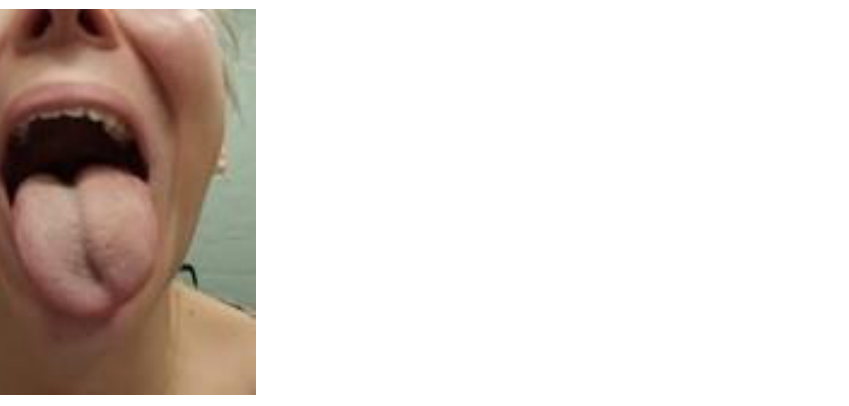
Figure 6. The patient’s photo before starting neuro-logopaedic therapy (January 2021). Visible left-sided pseudohypertrophy of the tongue and tongue deviation to the left while it is protruded.